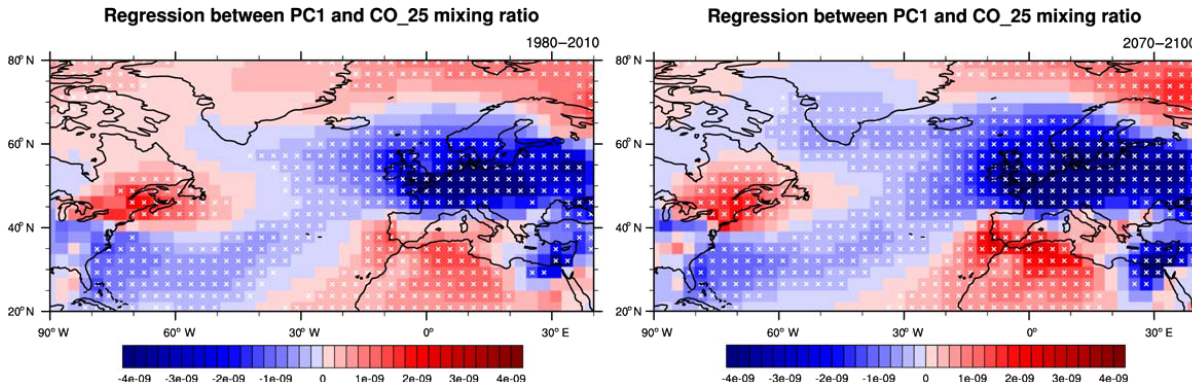
Figure 5. Regression of the winter seasonal CO_25 mixing ratio anomalies at surface level against the normalized PC1 computed for the recent past (left) and future (right) periods. The unit is molmol − 1 and the points marked with a white cross indicate local significance at the 95%.